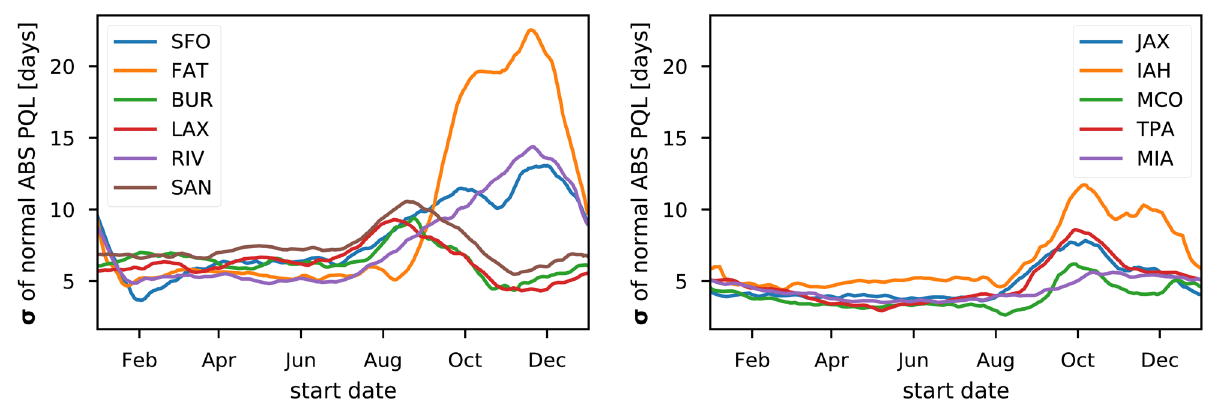
Figure 4. Variation in predicted quarantine length for each site and start date based on 95% of MED-FOES agent-based simulations showing